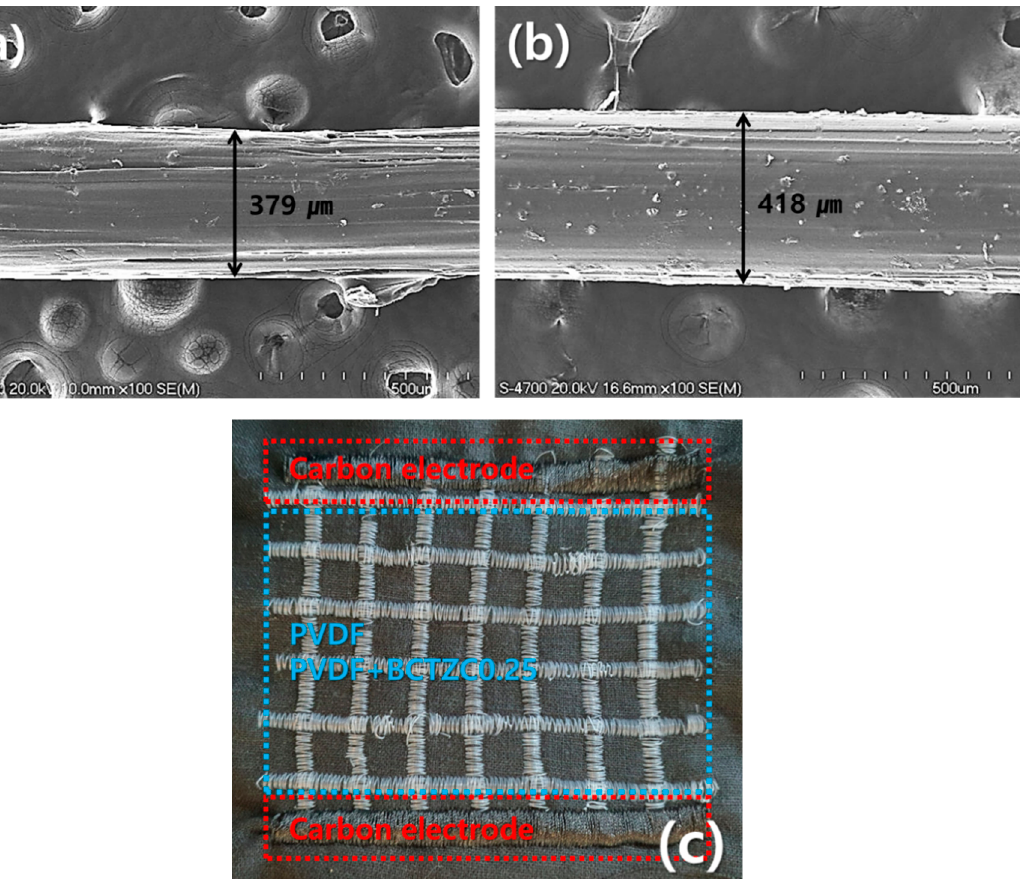
Figure 3. Surface field emission-scanning electron microscope (FE-SEM) images of the ( a ) PVDF fiber, ( b ) PVDF fiber with BCTZC0.25 (5.0 wt%), and ( c ) fiber generator (size: 10 × 10 cm 2